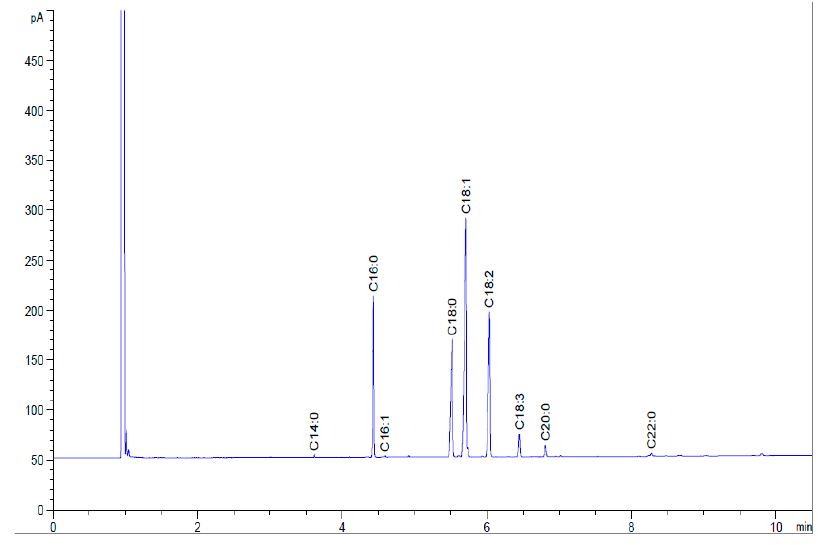
Figure 10. Chromatogram of HRNOB. Table 8. Fatty acid profile of HRNOB.